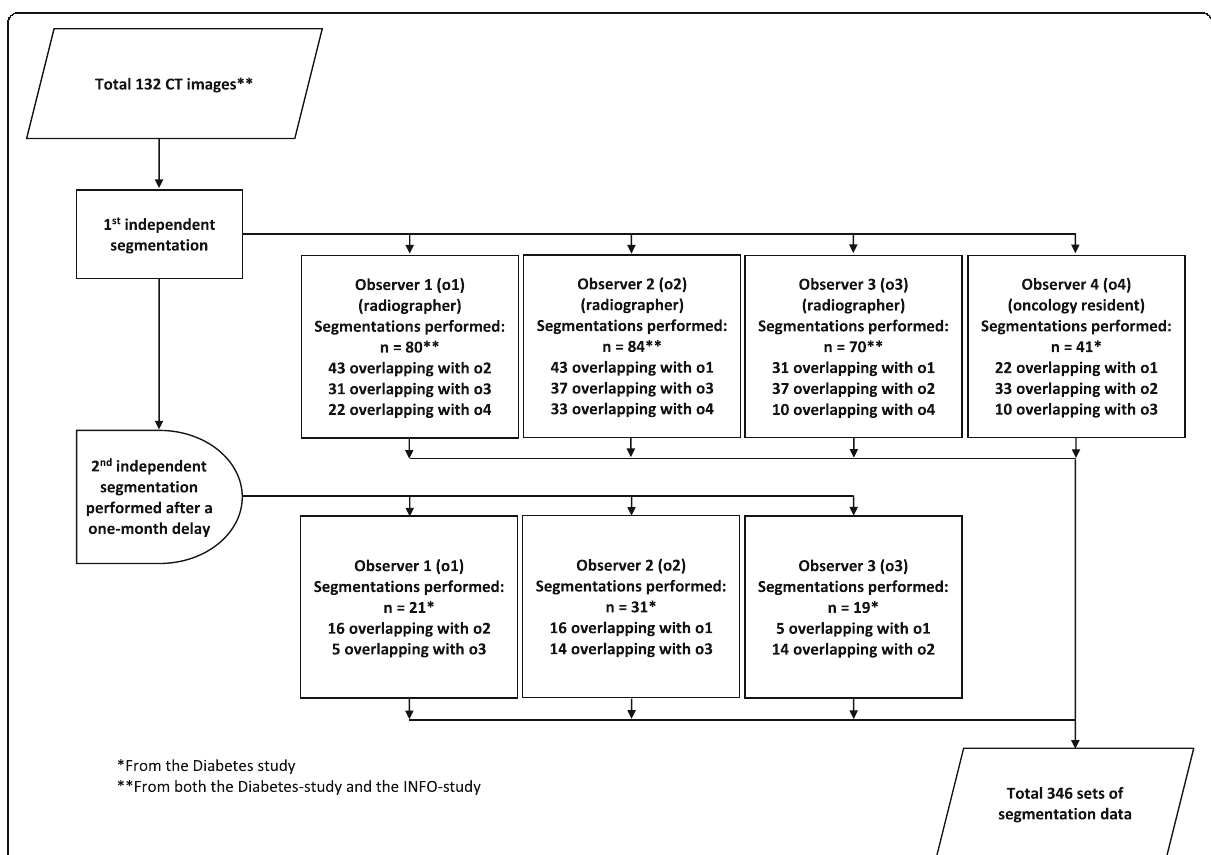
Fig. 2 Distribution of segmentation between observers. Segmentation of each CT image was performed by two or more observers to evaluate interobserver variation. A repeated segmentation of a subset of CT images was performed after a 1-month delay to evaluate intraobserver